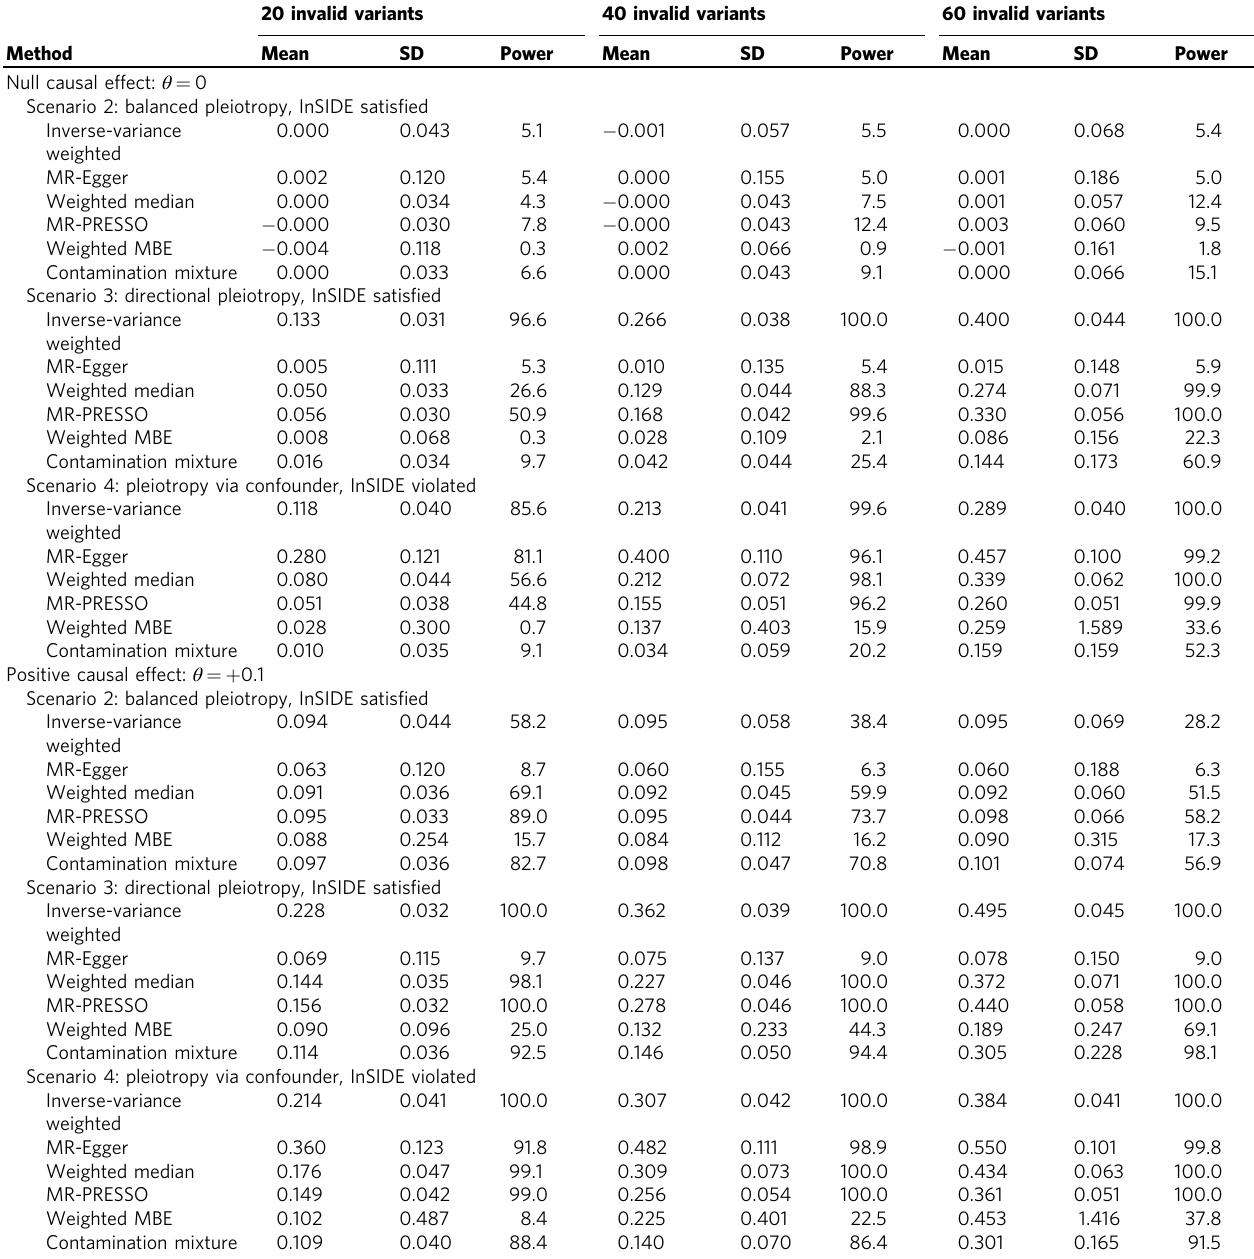
Table 2 Comparison of methods with some invalid instruments. 20 invalid variants